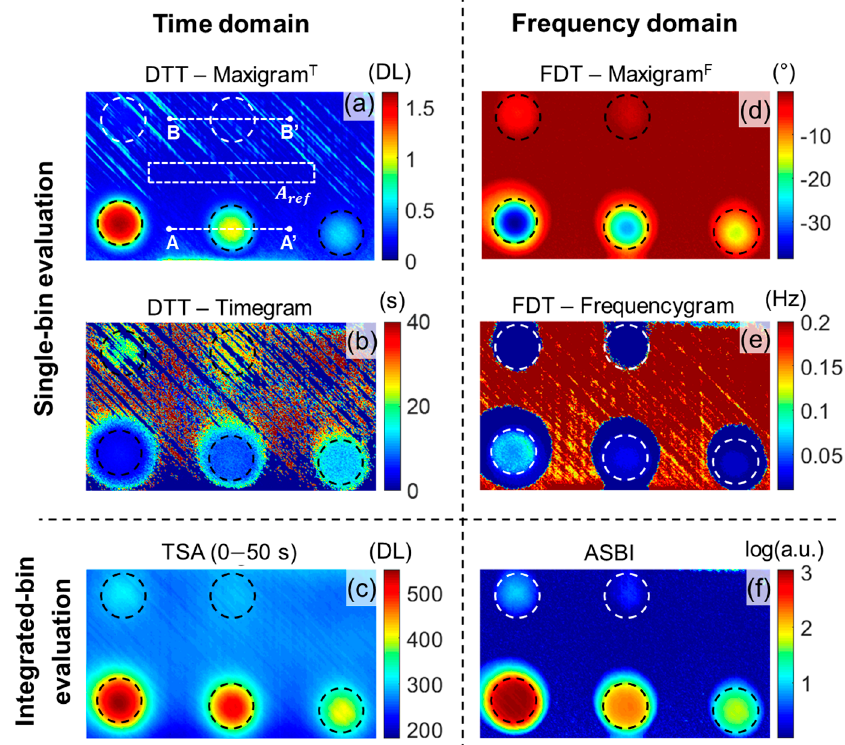
Figure 5. Results of processing techniques for the CFRP FBH coupon: ( a , b ) DTT maxigram T ∆ T max and timegram t ∆ T , max ; ( c ) TSA (0–50 s); ( d , e ) FDT maxigram F ∆ ϕ max and frequencygram f ∆ ϕ , max ; and ( f ) ASBI damage index map.